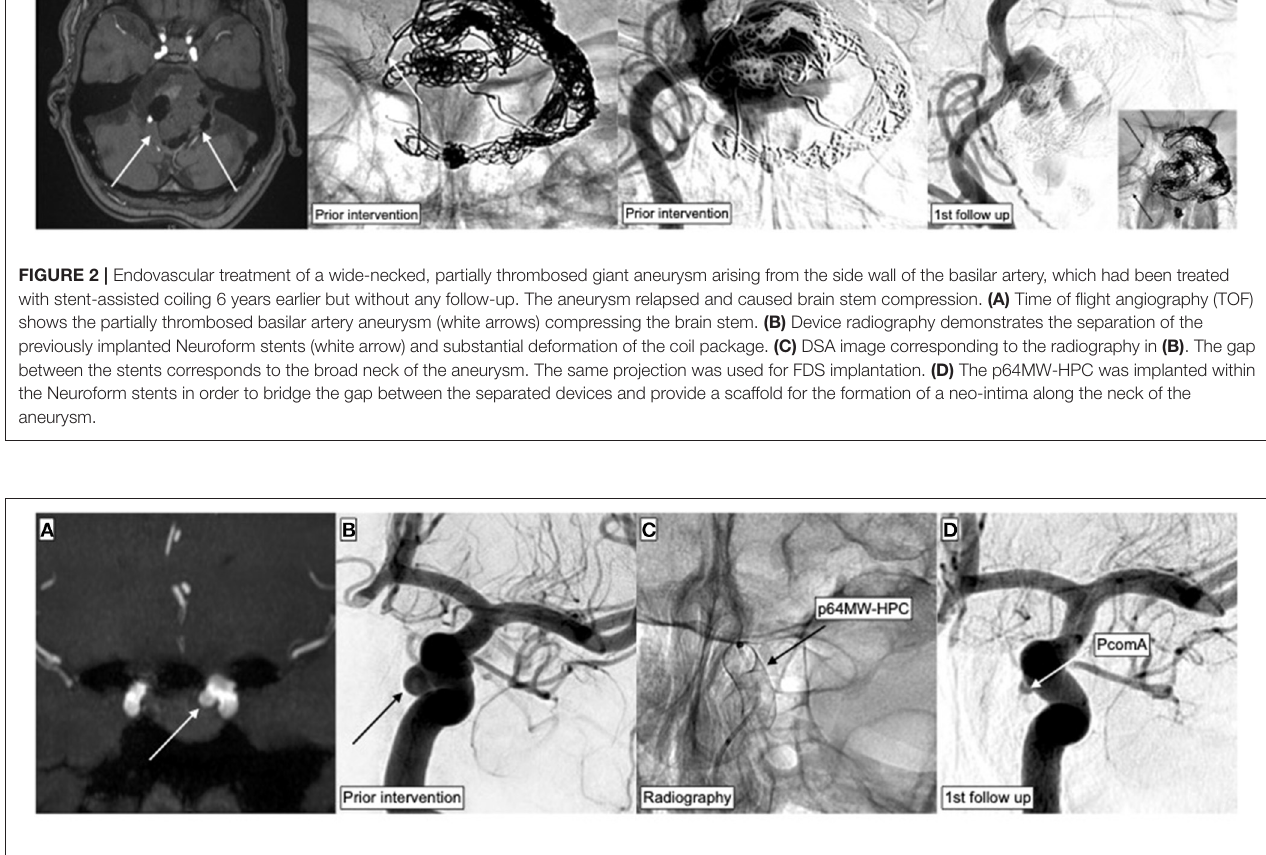
FIGURE 3 | Endovascular treatment of an incidental aneurysm arising from the left-handed side ICA. MRI was performed as preoperative imaging for planning of pituitary adenoma surgery. The growth-hormone-secreting adenoma had caused acromegaly. After detection of the aneurysm, decision was made for preceding flow diversion in order to facilitate future transsphenoidal resection without increased risk for arterial bleeding. (A) TOF-angiography maximum intensity projection (MIP) demonstrates the 4.5-mm measuring ICA aneurysm and its anatomical relationships. (B) Corresponding DSA in posterior–anterior projection demonstrates the aneurysm (black arrow) prior to treatment. (C) Radiography immediately after implantation of the p64MW-HPC in a posterior–anterior projection, matching (B,D) . (D) First follow-up DSA after 3.5 months in posterior–anterior projection; the aneurysm is completely